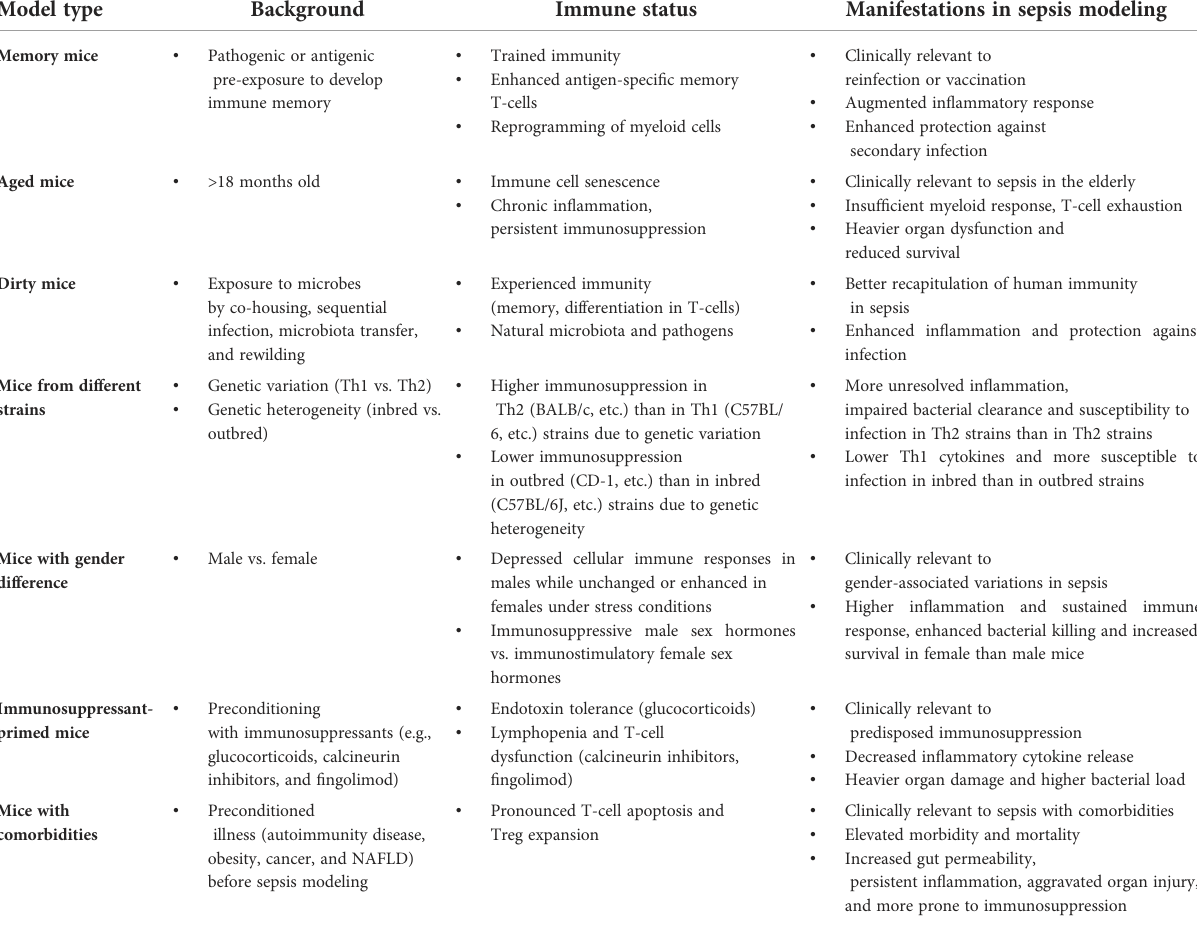
TABLE 2 Summary of mouse models with speci fi c immunologically characteristics to study immunosuppression in sepsis. Model